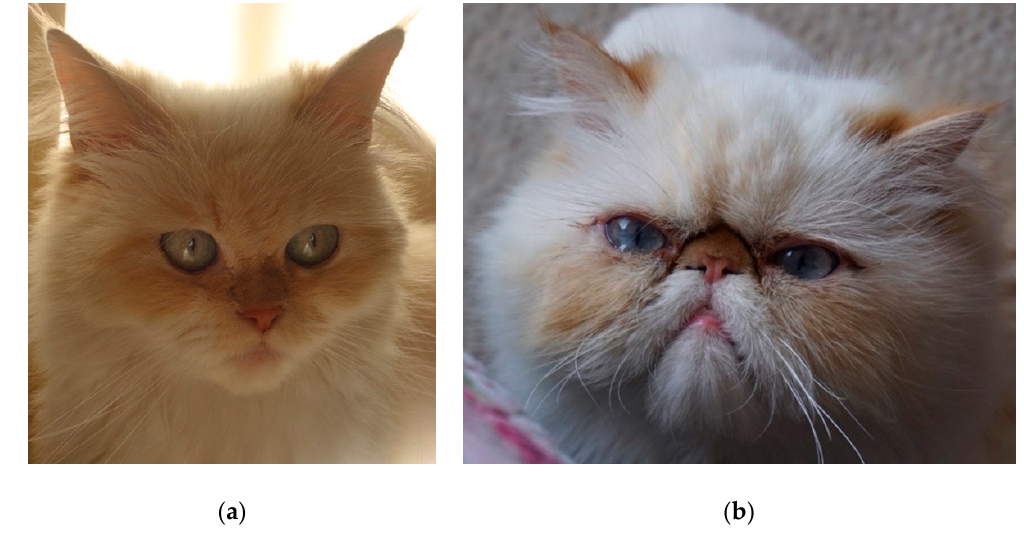
Figure 1. Traditional (´doll-face´) ( a ) vs. modern type (´peke-face´) ( b ) Persian cat.